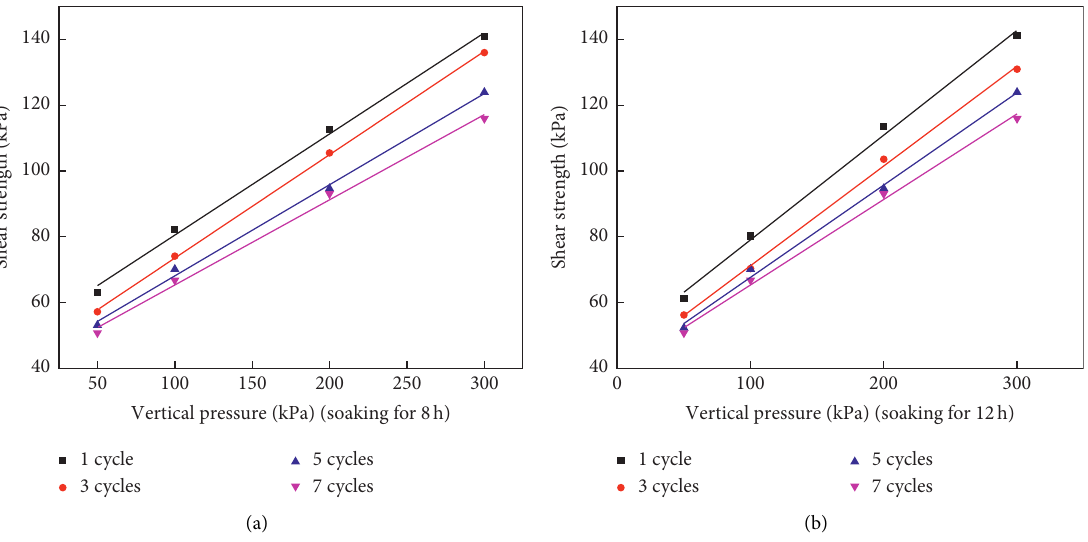
Figure 9: Results of direct shear test fitting (8h and 12h).